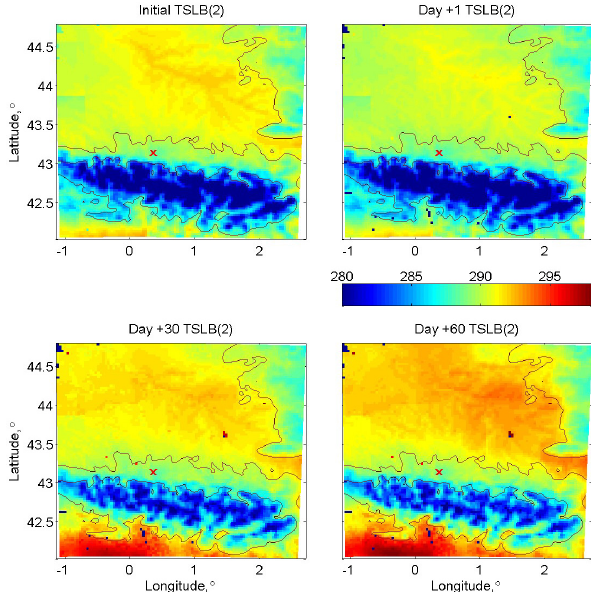
Figure 3. Soil temperature (K) in the second layer on the inner do- main at different times in the cycling experiments. Initial time is 00:00UTC on 1 June 2011. The red X is the Lannemezan measure- ment site. Elevation contours are plotted at 200 and 1000ma.s.l.